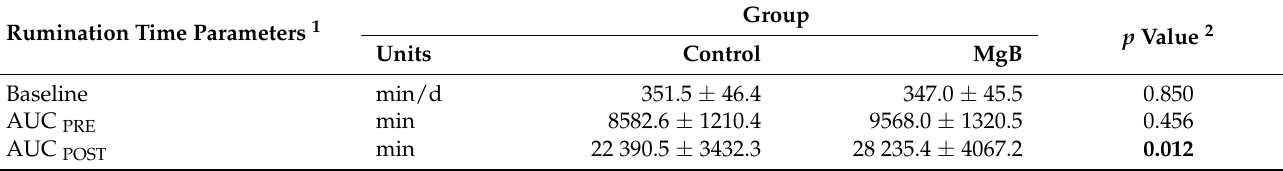
Prepartum and postpartum rumination time calculated as area under the curve (means ± SD) in dairy cows with (MgB, n = 34) and without (Control, n = 31) prepartum